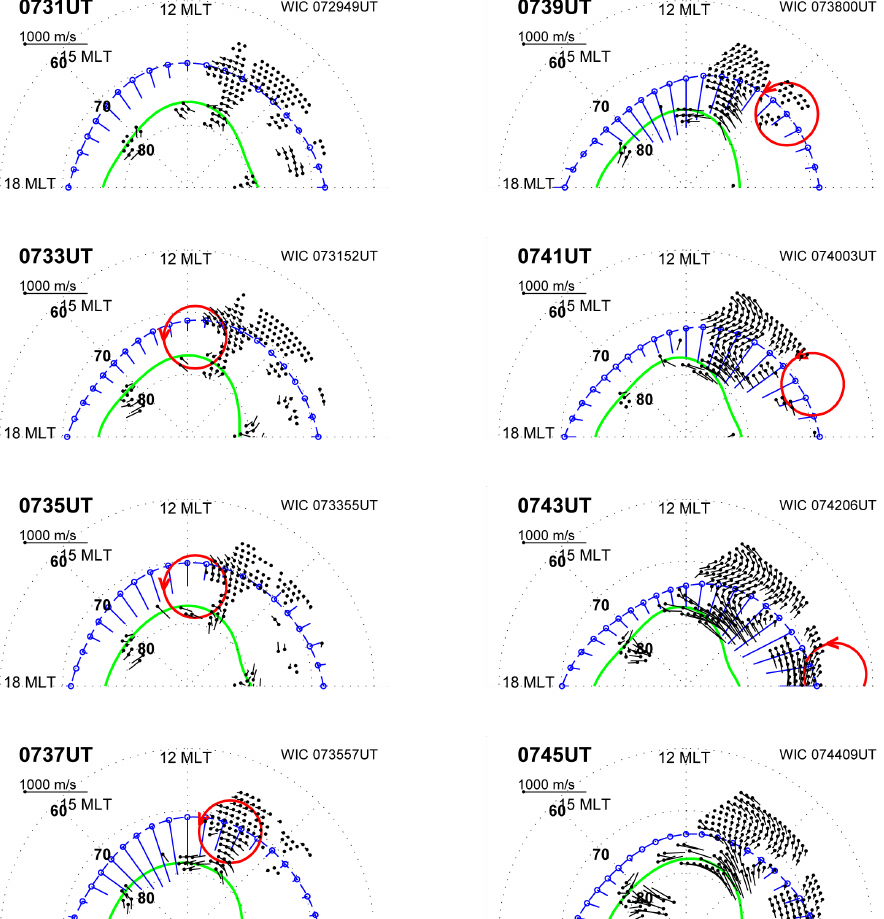
Fig. 9. A sequence of residual SuperDARN convection patterns illustrating the convection disturbance launched by the sudden impulse. Blue lines indicate the position of the middle part of the auroral oval, and the vectors show the direction and apparent velocity of the poleward shift of the oval at that moment. Red circles represent the convection vortex expected to be present in front of the propagating disturbance. Green line shows the poleward boundary of the auroral